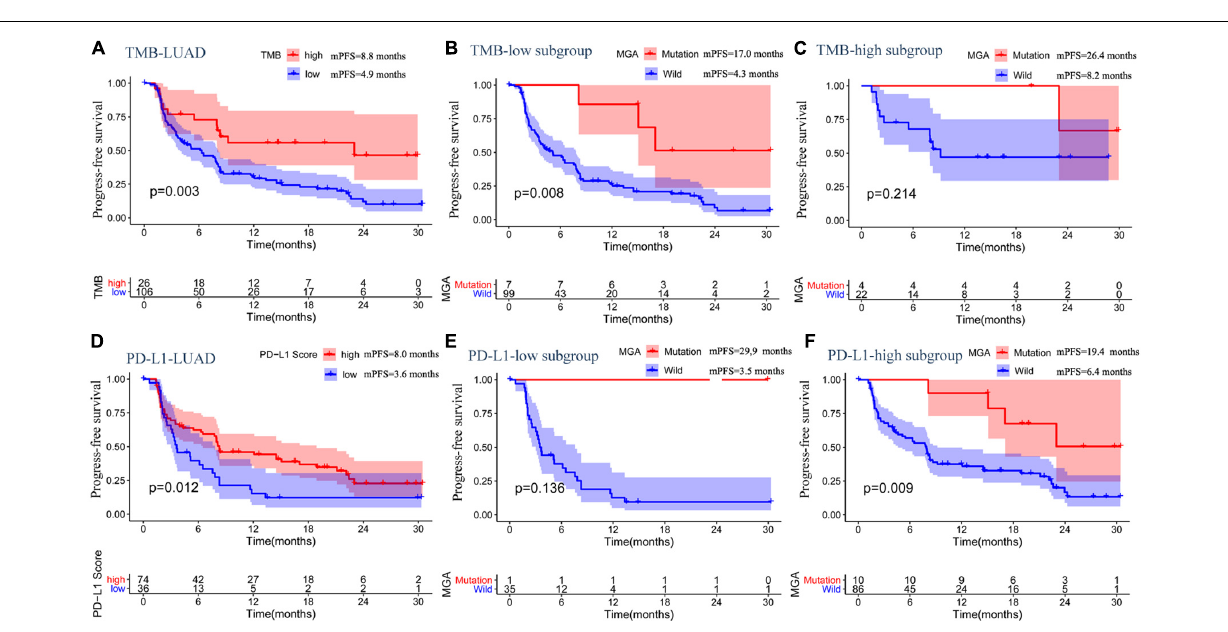
Frontiers in Cell and Developmental Biology |